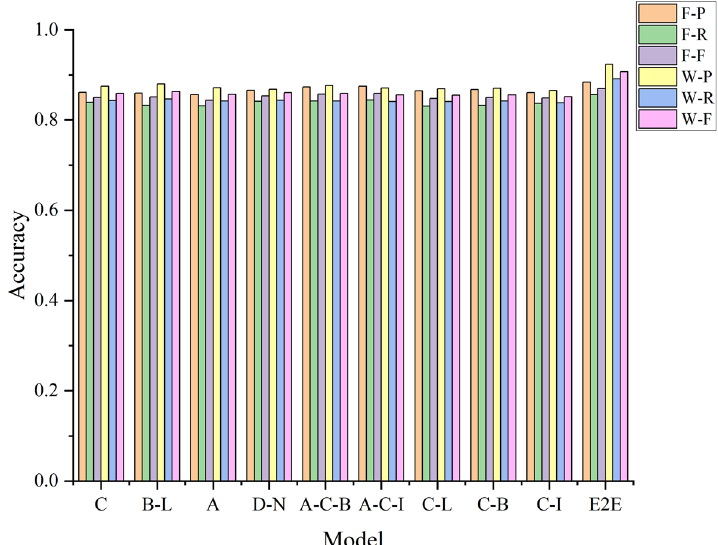
Figure 10. Effect of different deep learning on the evaluation criteria values for UAV images.